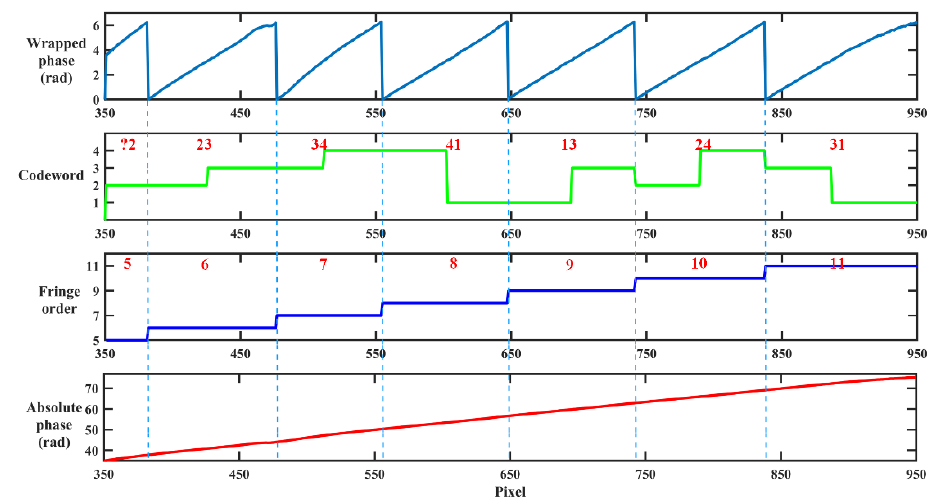
Figure 8. The 400th cross-section of two isolated sculptures. The comparative experiments in the proposed method and the method in Ref. [32] were also set up. The results of the two methods are presented in Figure 9a,b. It can be seen that both methods can reconstruct Doraemon well and the reconstructions have a smooth surface, confirming the good performance of the proposed method when measuring a complex object.